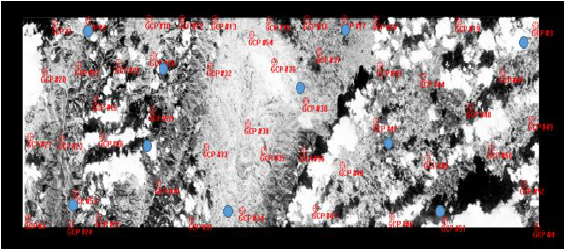
Figure 5. GCPs selection and check points (blue is check point)